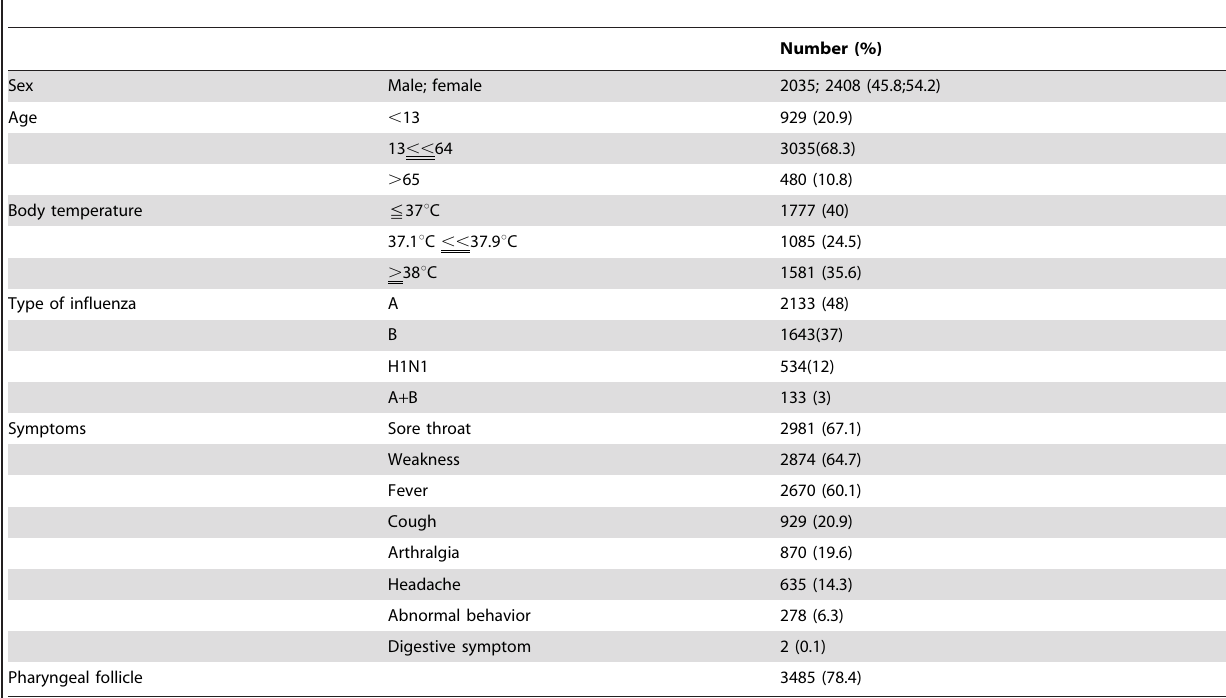
Table 2. Clinical characteristics of participants with seasonal